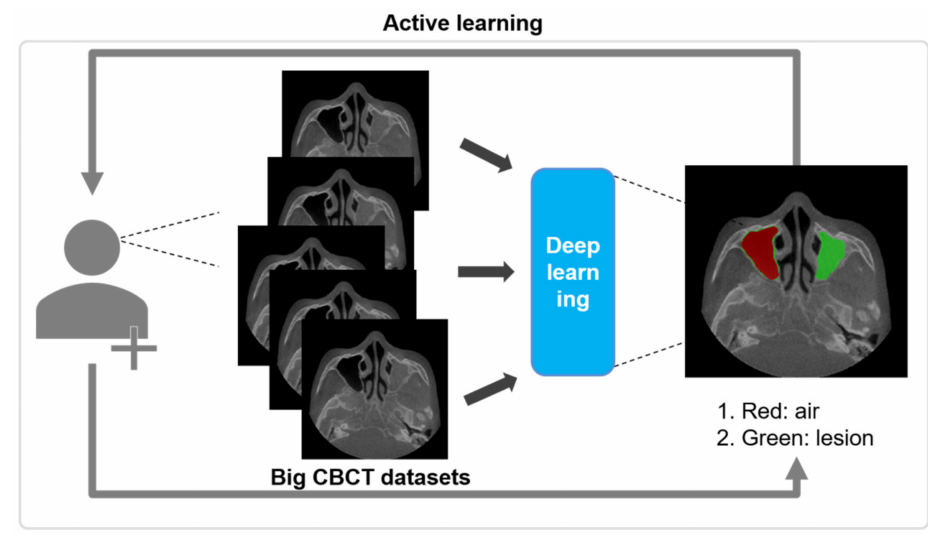
Figure 2. Overall process for the active learning for maxillary sinus segmentation on